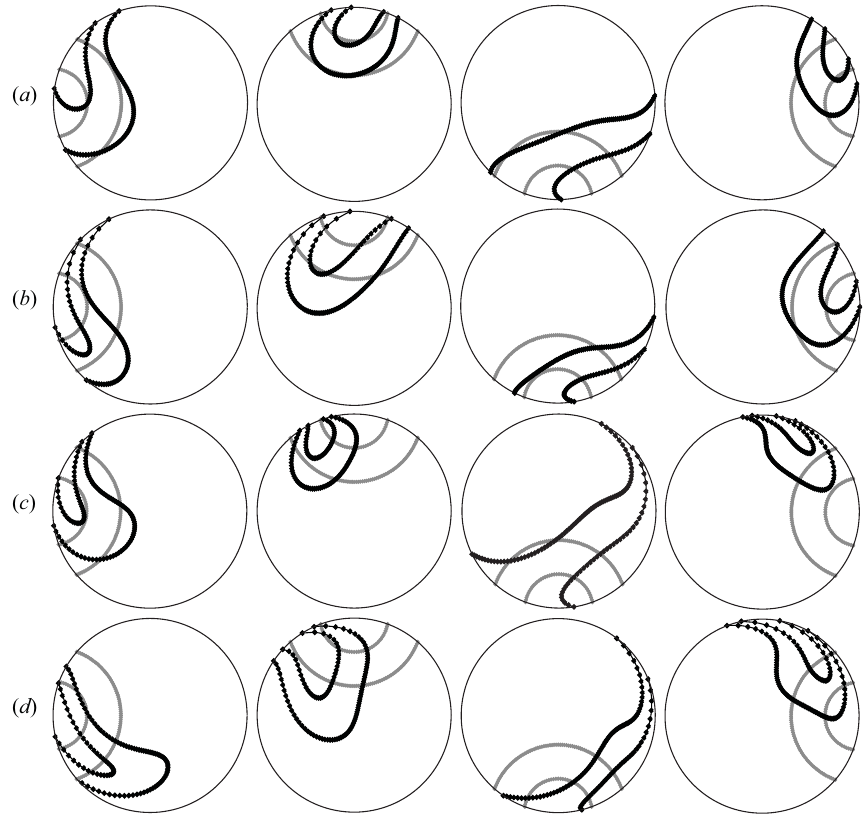
Fig. 4. Snap shots of several cloud patches at t = T i (row- a ), t = 2 T i (row- b ), t = 3 T i (row- c ) and t = 4 T i (row- d ). Grayed points represent the initial position of particles. A uniform wind stress of W = 1 is applied for 0 <t <T i / 3 from the left to the right. The background velocity field contains the geostrophic flows (during only the wind event) and the Kelvin and the Poincar´e wave modes of the lowest two vertical modes. ( B = 2, h 2 = 1, h 3 =